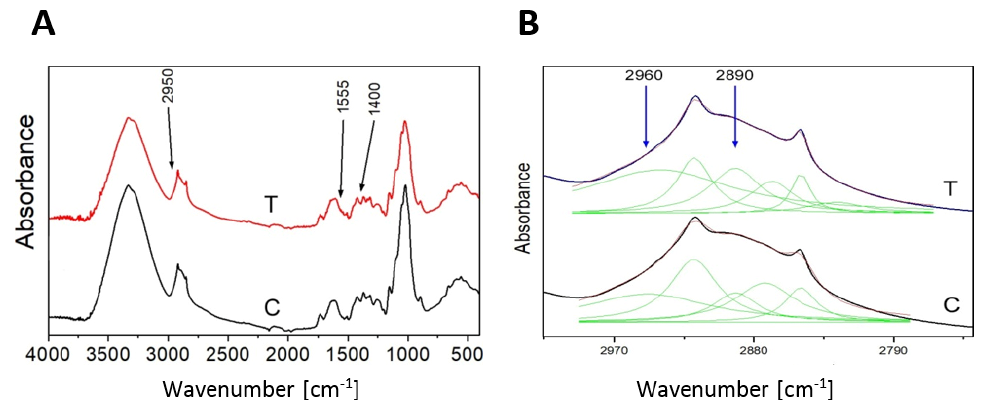
Figure 3. FT-IR spectrum of control (C) and transgenic sample (T) as an example ( A ). The deconvolution of the contour 2800–3000 cm − 1 into the Lorentz components ( B ).